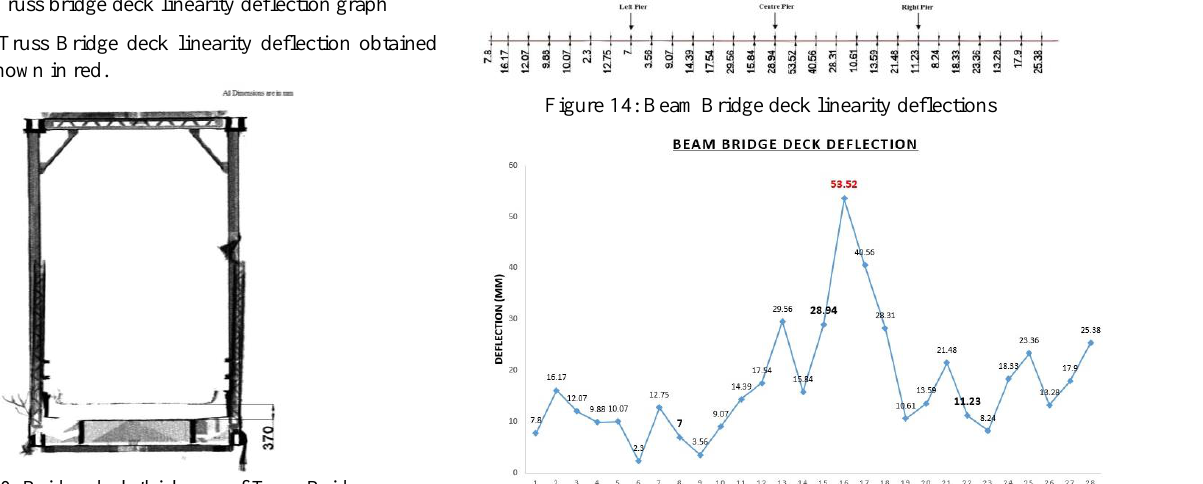
Figure 10: Bridge deck thickness of Truss Bridge The Truss Bridge deck thickness obtained is 370mm.